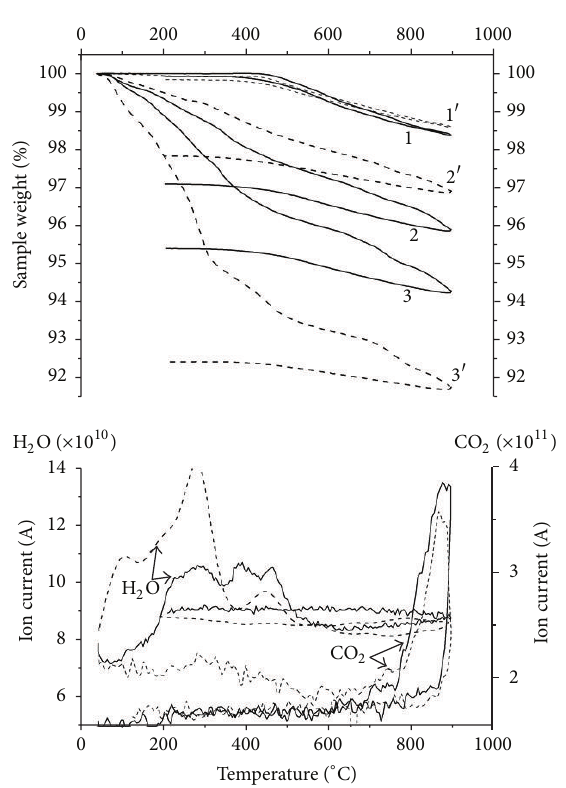
Figure 7: Thermal analysis results for samples: Y-0 (1), N-0 (1 󸀠 ); Y- 2 (2), N-2 (2 󸀠 ) and Y-10 (3), N-10 (3 󸀠 ). Mass spectrometry data are related to the samples Y-10 (solid curves) and N-10 (dashed